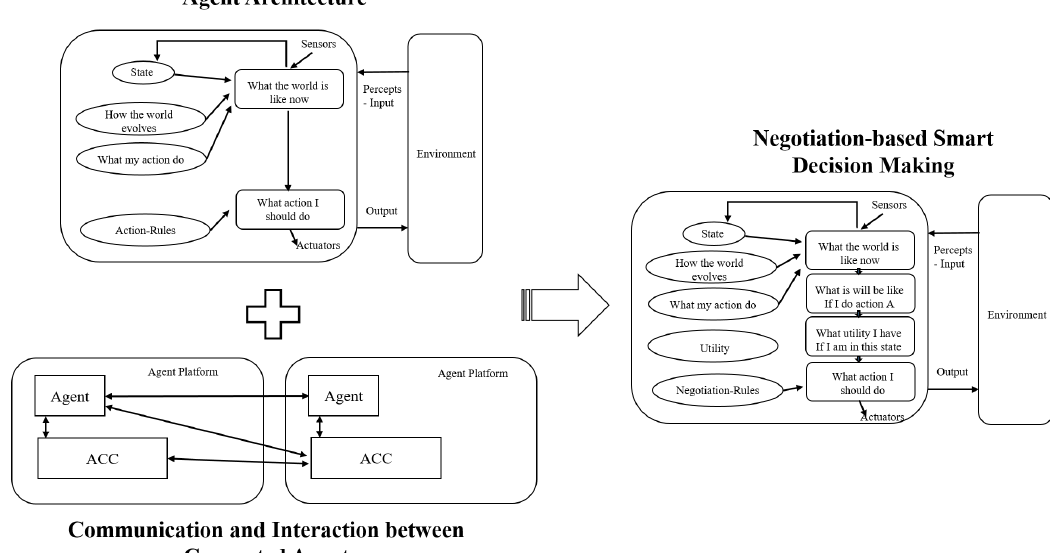
Figure 3. The evolution of intelligent